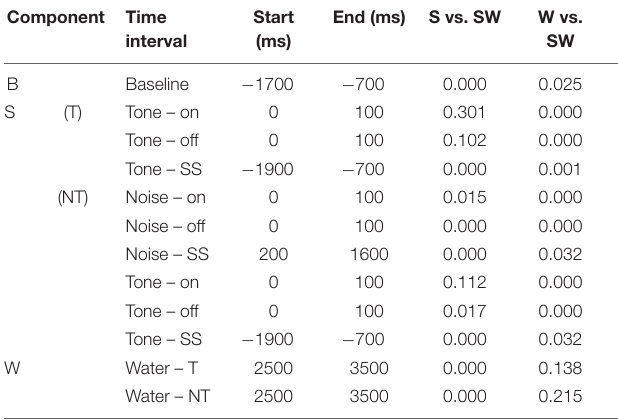
Results are based on 75 multiunits. Other conventions as in Table 1 . TABLE 4 | P -values of the comparisons shown in Table 3